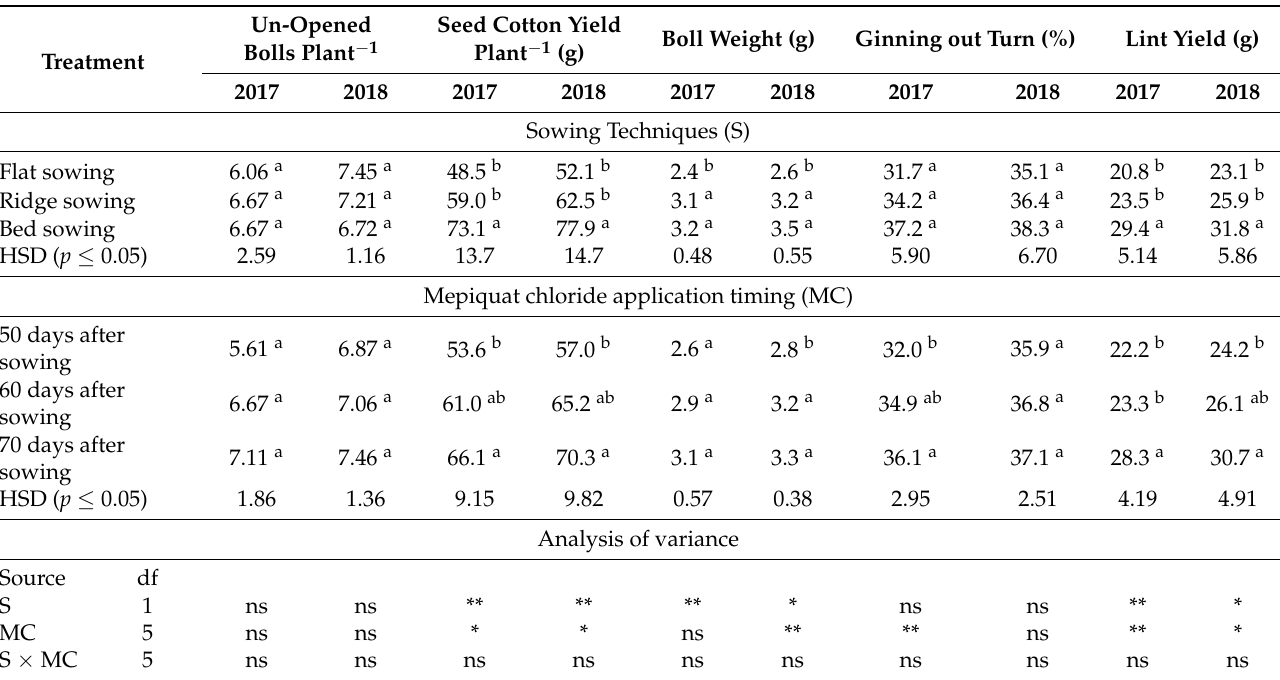
Table 2. Effect of different sowing techniques and timing of mepiquat chloride application on morphological and yield-related attributes of cotton.